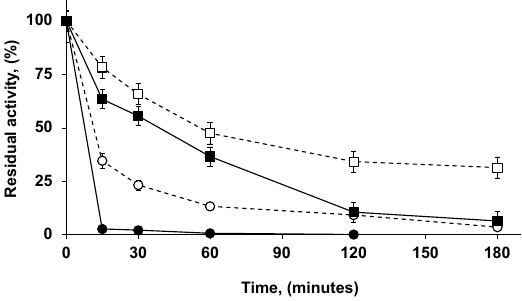
Figure 4. Inactivation courses of different lipase biocatalysts at pH 7.0 and 60 °C. Dotted line, empty squares: octyl-VS-PEI-RML; dotted line, empty circles: octyl-VS-PEI-LEU; solid line, solid squares: octyl-RML and solid line, solid circles: octyl-LEU. Other specifications are described in Methods.